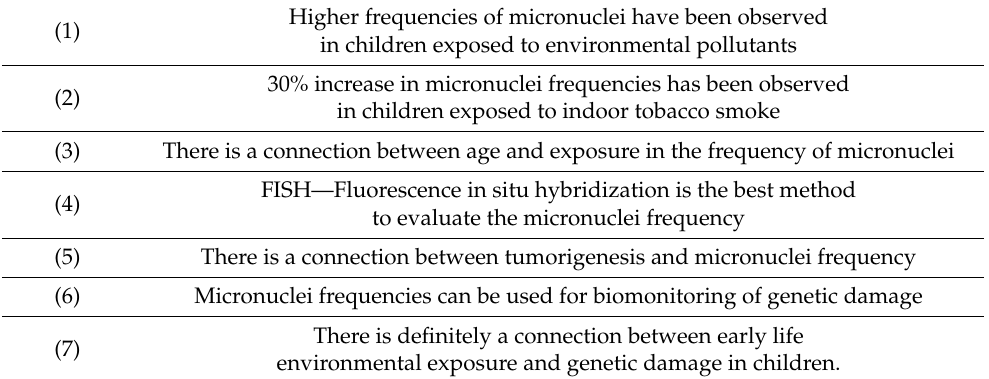
Table 1. Micronuclei and